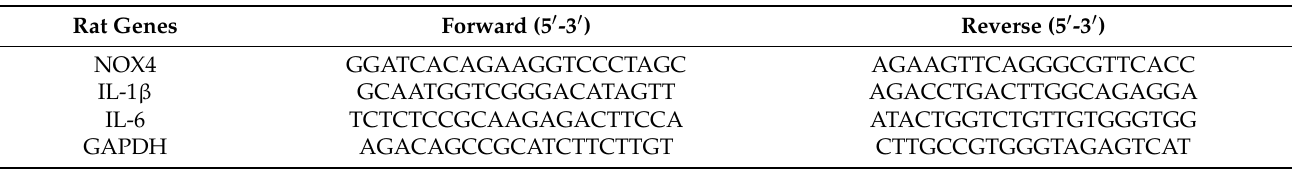
Table 1. Rat primers used for real-time